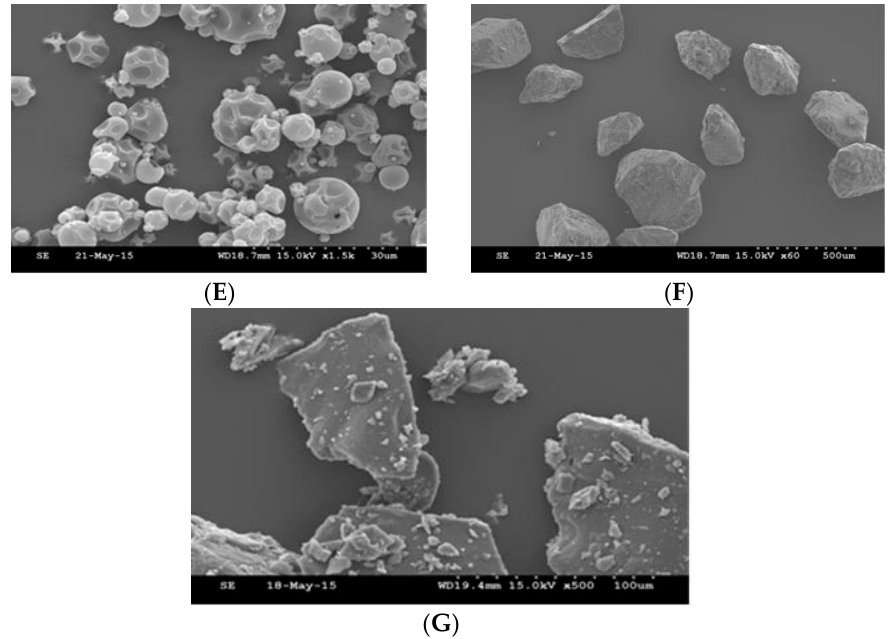
Figure 10. ( A–G ): Scanning Electron Microscopy (SEM) for lyophilized samples and pure excipients. ( A ) Pure drug; ( B ) Drug and gluconolactone 1:5; ( C ) Drug and hydroxyl propyl γ -cyclodextrin 1:5; ( D ) Drug and trehalose 1:5; ( E ) Pure hydroxyl propyl γ -cyclodextrin; ( F ) Pure gluconolactone; ( G ) Pure trehalose.